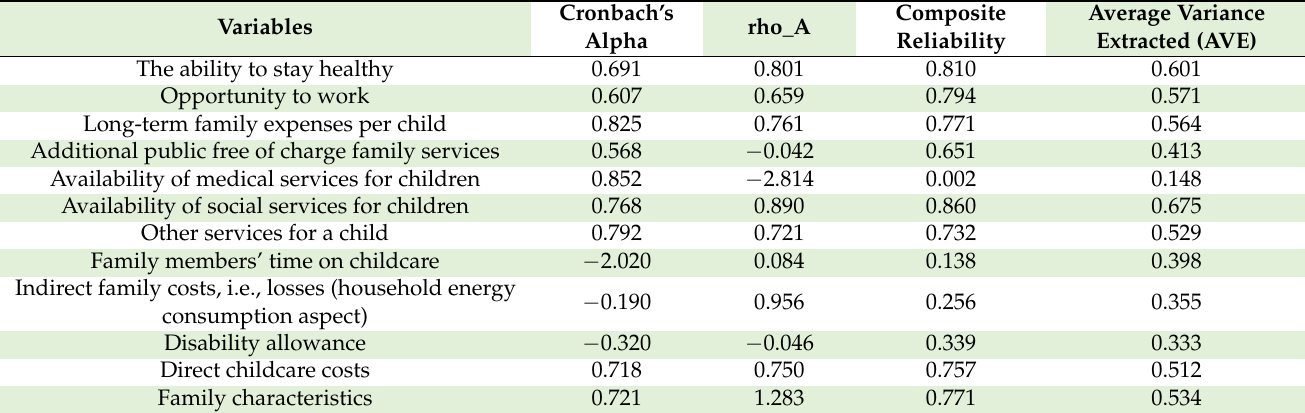
Table 2. Reliability and validity coefficients.